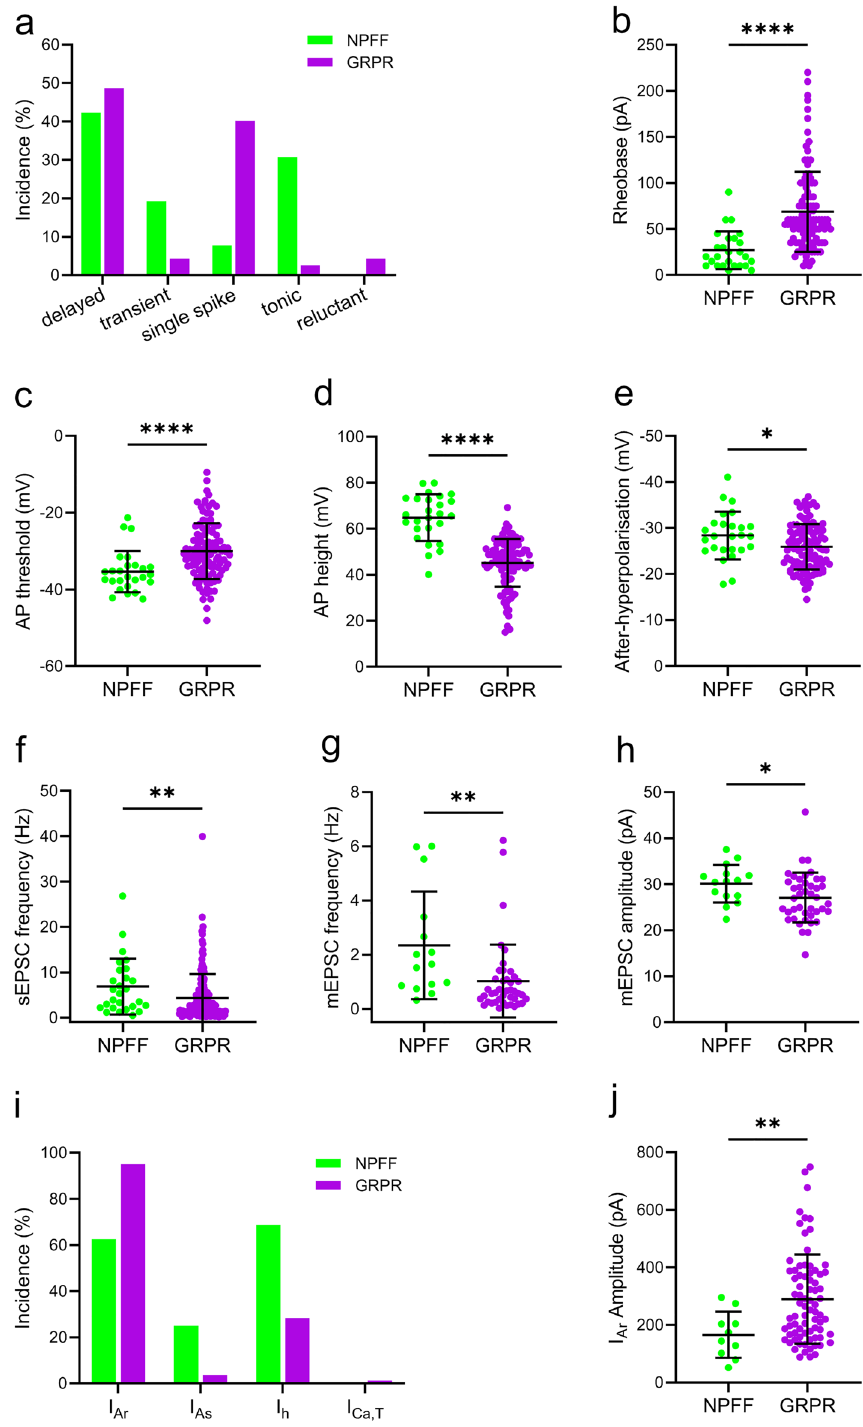
Figure 11. Comparison of the electrophysiological properties of NPFF cells with those of GRPR cells. Data for the GRPR cells was obtained from Polgár et al 18 . ( a ) The incidence of action potential firing patterns differed between NPFF and GRPR cells. NPFF cells exhibited a greater proportion of tonic (30.8 vs. 2.6%) and initial burst firing (19.2 vs. 4.3%) cells and fewer single spike firing cells (7.7 vs. 40.2%). The incidence of delayed firing was similar between both cell types (42.3 vs. 48.7%). NPFF cells were found to have a lower rheobase (26.9 ± 20.5 v.s 68.7 ± 43.4 pA, P < 0.0001, b ), action potential voltage threshold (-35.3 ± 5.4 vs. -30.0 ± 7.3 mV, P < 0.0001, c ) and a greater action potential height (64.8 ± 10.2 vs. 45.2 ± 10.4 mV, P < 0.0001, d ) and after-hyperpolarisation (-28.4 ± 5.2 vs. − 25.9 ± 4.9 mV, P = 0.024, e ). In terms of excitatory synaptic input, sEPSC (6.86 ± 6.15 vs. 4.34 ± 5.26 Hz, P = 0.005, f ) and mEPSC (2.35 ± 1.99 vs. 1.02 ± 1.34 Hz, P = 0.002, g ) frequency in NPFF cells was greater than that in GRPR cells, as was the mEPSC amplitude (30.1 ± 4.1 vs. 27.1 ± 5.4 pA, P = 0.023, h ). ( i ) The incidence of subthreshold voltage-activated currents differed between NPFF and GRPR cells. NPFF cells demonstrated a higher incidence of I As (25.0 vs. 3.7%) and I h (68.8 vs. 28.4%), but a lower incidence of I Ar (62.5 vs. 95.1%). ( j ) The peak amplitude of the I Ar recorded in NPFF cells was significantly lower than for GRPR cells (165.7 ± 80.3 vs. 289.7 ± 154.7, P = 0.007). All statistical comparisons made using a Mann Whitney test, except for afterhyperpolarisation, which was compared using an unpaired t